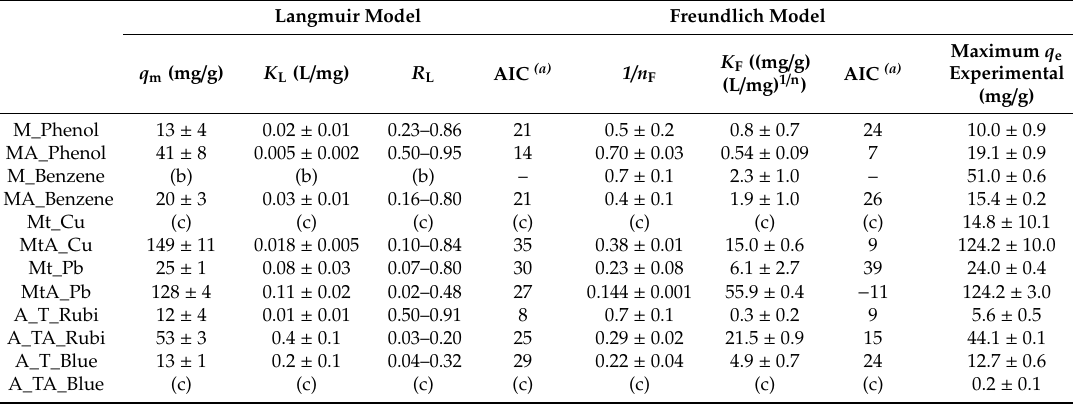
Table 4. Parameters of non-linear Langmuir and Freundlich isotherms.